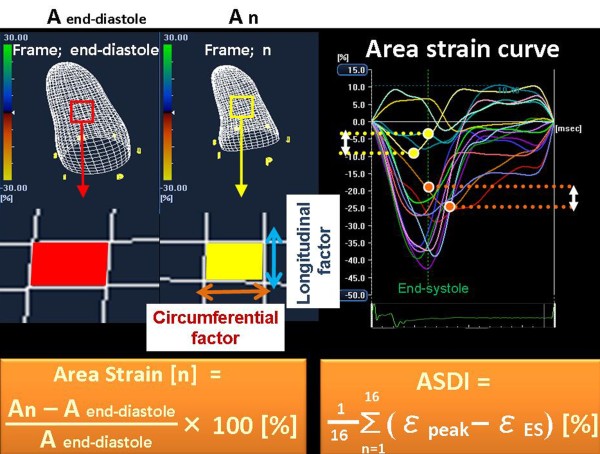
The left panel shows the concept of three-dimensional (3-D) area strain. Area strain expresses how the change in a regional area of the endocardium in a phase vs. that in the diastolic phase. Area strain is combined with both 3-D longitudinal and circumferential factors. The right panel shows an example of the strain dyssynchrony index using area tracking (ASDI). ASDI was calculated as the wasted energy per segment due to dyssynchrony and was determined by using the average difference between peak strain (ε-peak) and end-systolic strain (ε-ES) from 16 segments.